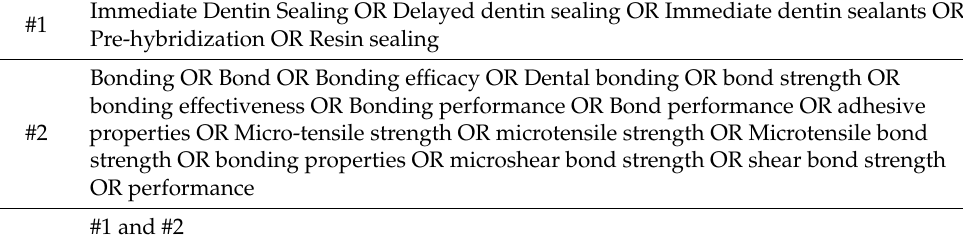
Table 3. Search strategy used in